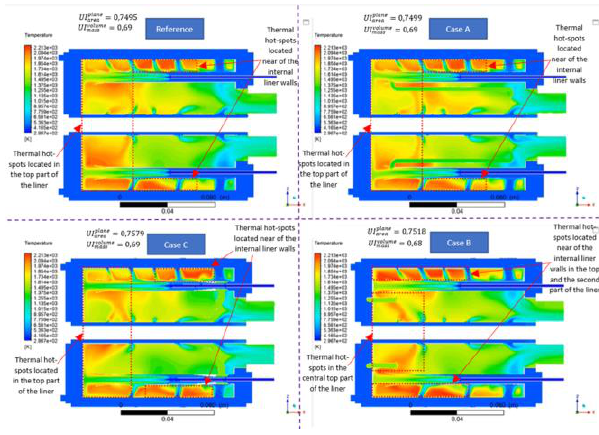
Fig. 8. Static temperature [K] field